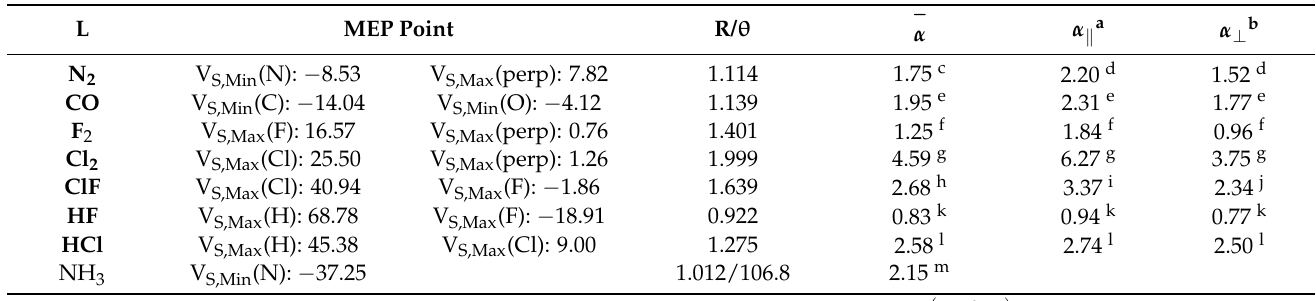
Table 3. MP2/aVTZ values (kcal mol − 1 , 0.0010 ea 0 − 3 isodensity surface) at the minimum ( V S,Min ) or maximum ( V S,Max ) points of the MEP calculated at the MP2/aVTZ optimized geometries (Å and ◦ ), and experimental polarizabilities α (Å 3 ) of L . L MEP